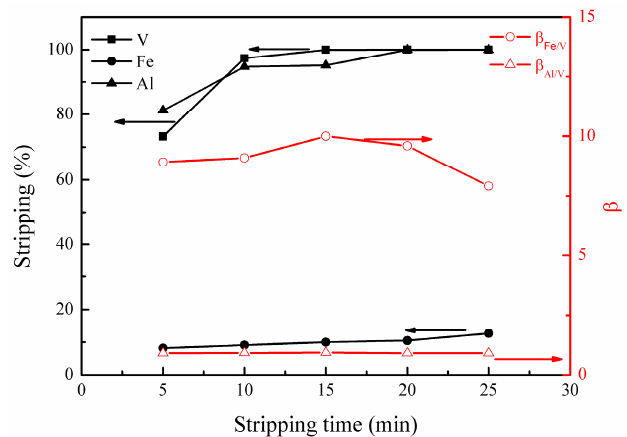
Figure 6. Effect of stripping time on the stripping percentages of V (IV), Fe, and Al, as well as on the separation factors β Fe/V and β Al/V .